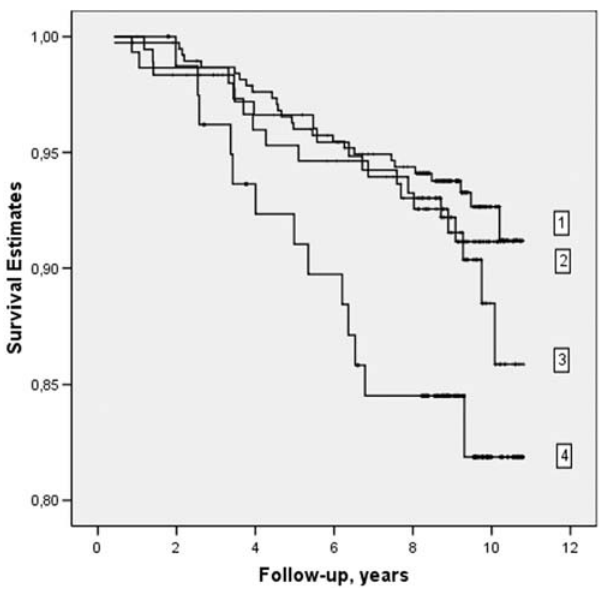
Figure 1. Kaplan-Meier survival curves for 1) study subjects with lower serum total homocysteine (tHcy , 11.28 m mol/L) and no COMT Met158- Met genotype, 2) study subjects with higher serum tHcy ( $ 11.28 m mol/ L) and no COMT Met158Met genotype, 3) study subjects with lower serum tHcy and COMT Met158Met genotype, and 4) study subjects with higher serum tHcy and COMT Met158Met